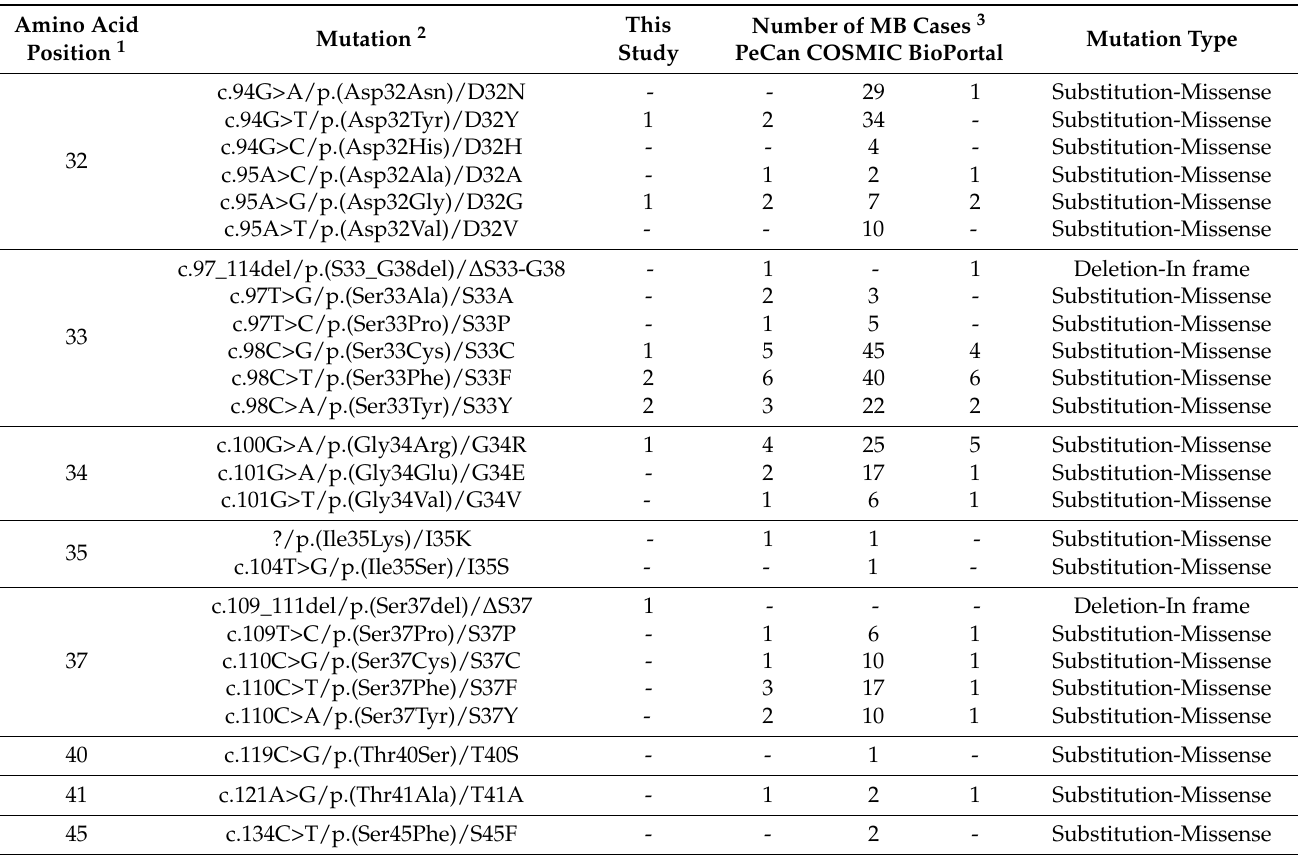
Table 1. CTNNB1 mutations found in medulloblastoma tumor samples and in our